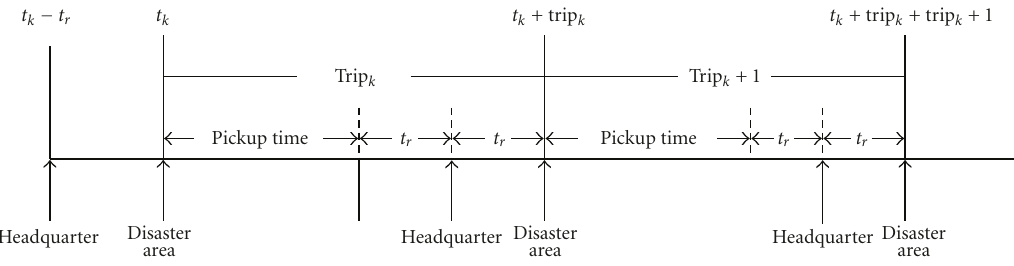
Figure 2: The trips of a